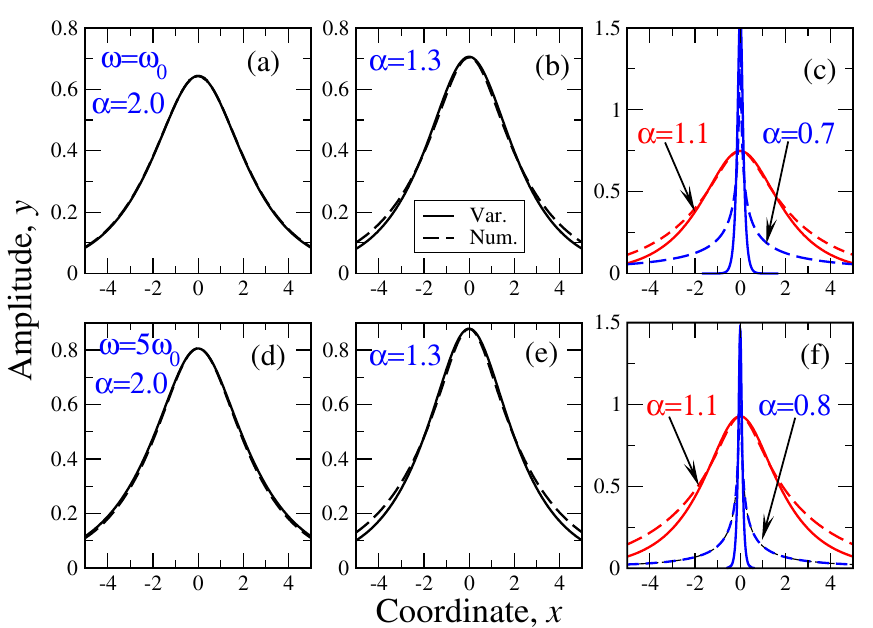
Figure 4. Comparison of numerical (dashed lines) and variational (solid lines) solutions of the fractional soliton equation (7) for different frequencies (in the units of ω 0 , see legends in (a) and (d)) and Lévy indices α , shown in the legends. Upper row (panels (a),(b),(c)) corresponds to ω 5 ω 0 ω =